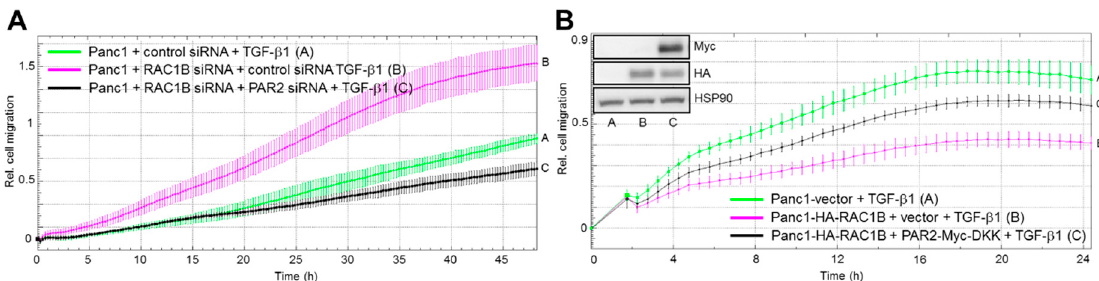
Figure 3. E ff ect of PAR2 depletion or ectopic overexpression on TGF- β -regulated chemokinesis in Panc1 cells with RAC1B knockdown or stable overexpression, respectively. ( A ) Panc1 cells were transfected twice with 25 nM each of Co siRNAs for RAC1B and PAR2, or 25 nM each of RAC1B siRNA and PAR2-specific Co siRNA, or 25 nM RAC1B siRNA + 25 nM PAR2 siRNA. Forty-eight hours after the second round of transfection, cells were assayed for migratory activity on an xCELLigence platform in the presence of TGF- β 1. The graph shows a representative experiment. Data are the mean ± SD from 3–4 wells per condition. Di ff erences between Panc1 + RAC1B siRNA + PAR2 siRNA + TGF- β 1 (black curve, tracing C) and Panc1 + RAC1B siRNA + TGF- β 1 (magenta curve, tracing B) are significant at 01:00 and all later time points. Successful inhibition of RAC1B and PAR2 was verified by immunoblotting and qPCR analysis, respectively. ( B ) Panc1 cells with ectopic expression of HA-RAC1B (clone 4) were transiently transfected with Myc-DKK-tagged PAR2, or empty vector, and 48 h later subjected to real-time cell migration assay in the presence of TGF- β 1. Panc1 cells with stable expression of empty pCGN vector (Panc1-vector) rather than HA-RAC1B were used as control for the migration-inhibitory e ff ect of HA-RAC1B. Shown is a representative experiment (mean ± SD from 3–4 wells per condition). Di ff erences between Panc1-HA-RAC1B + PAR2-Myc-DKK + TGF- β 1 (black curve, tracing C) and Panc1-HA-RAC1B + empty vector + TGF- β 1 (magenta curve, tracing B) are significant at 04:00 and all later time points. Ectopic expression of HA-RAC1B and PAR2-Myc-DKK were verified in immunoblots using anti-HA and anti-Myc antibodies, respectively (inset). 2.4. PAR2 Knockdown Protects Cells from the RAC1B Knockdown-Mediated Increase in TGF- β